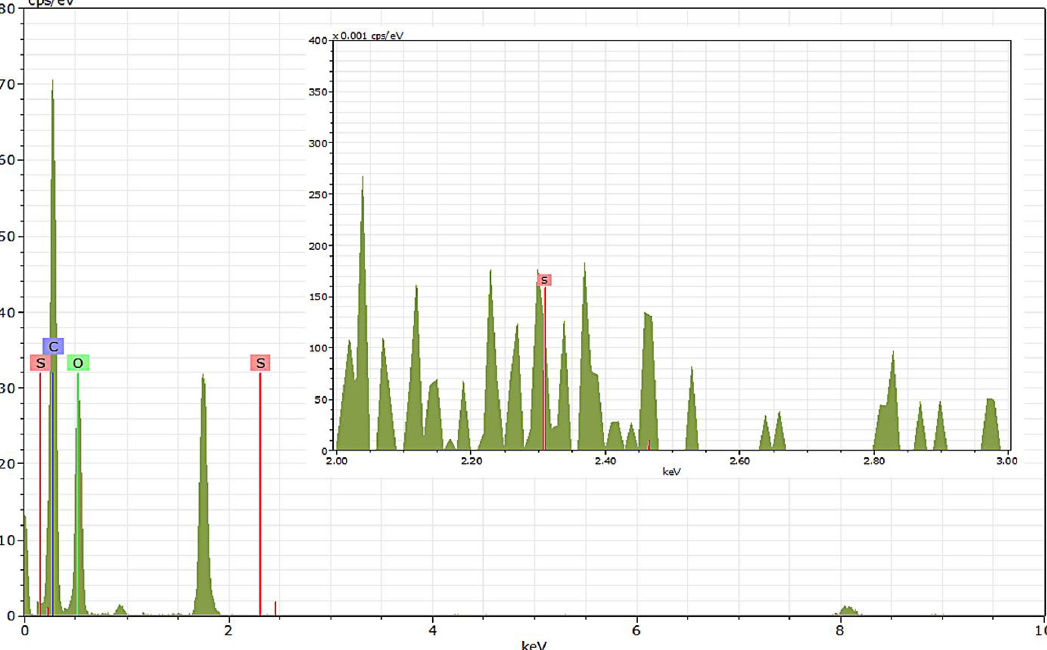
Figure C6. Energy-dispersive X-ray spectroscopy (EDX) spectra for AOI of bare mCASTblack soot presented in Fig. 10. The x axis stands for the electron energy (keV) and the y axis represents counts per second per eV (cpseV − 1 ). The position of carbon (C), oxygen (O) and sulfur (S) is indicated in the figure. The zoom-in patch shows the sulfur region of the spectra, which is not legible in the main spectrum.